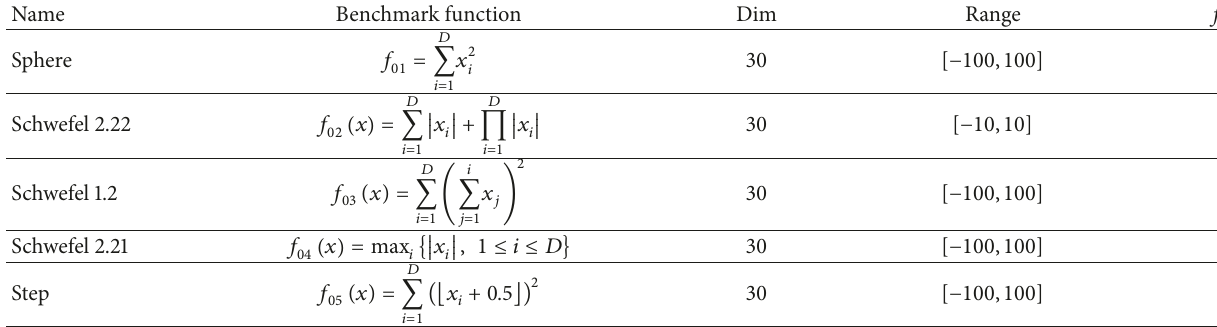
Table 1: Unimodal benchmark functions.